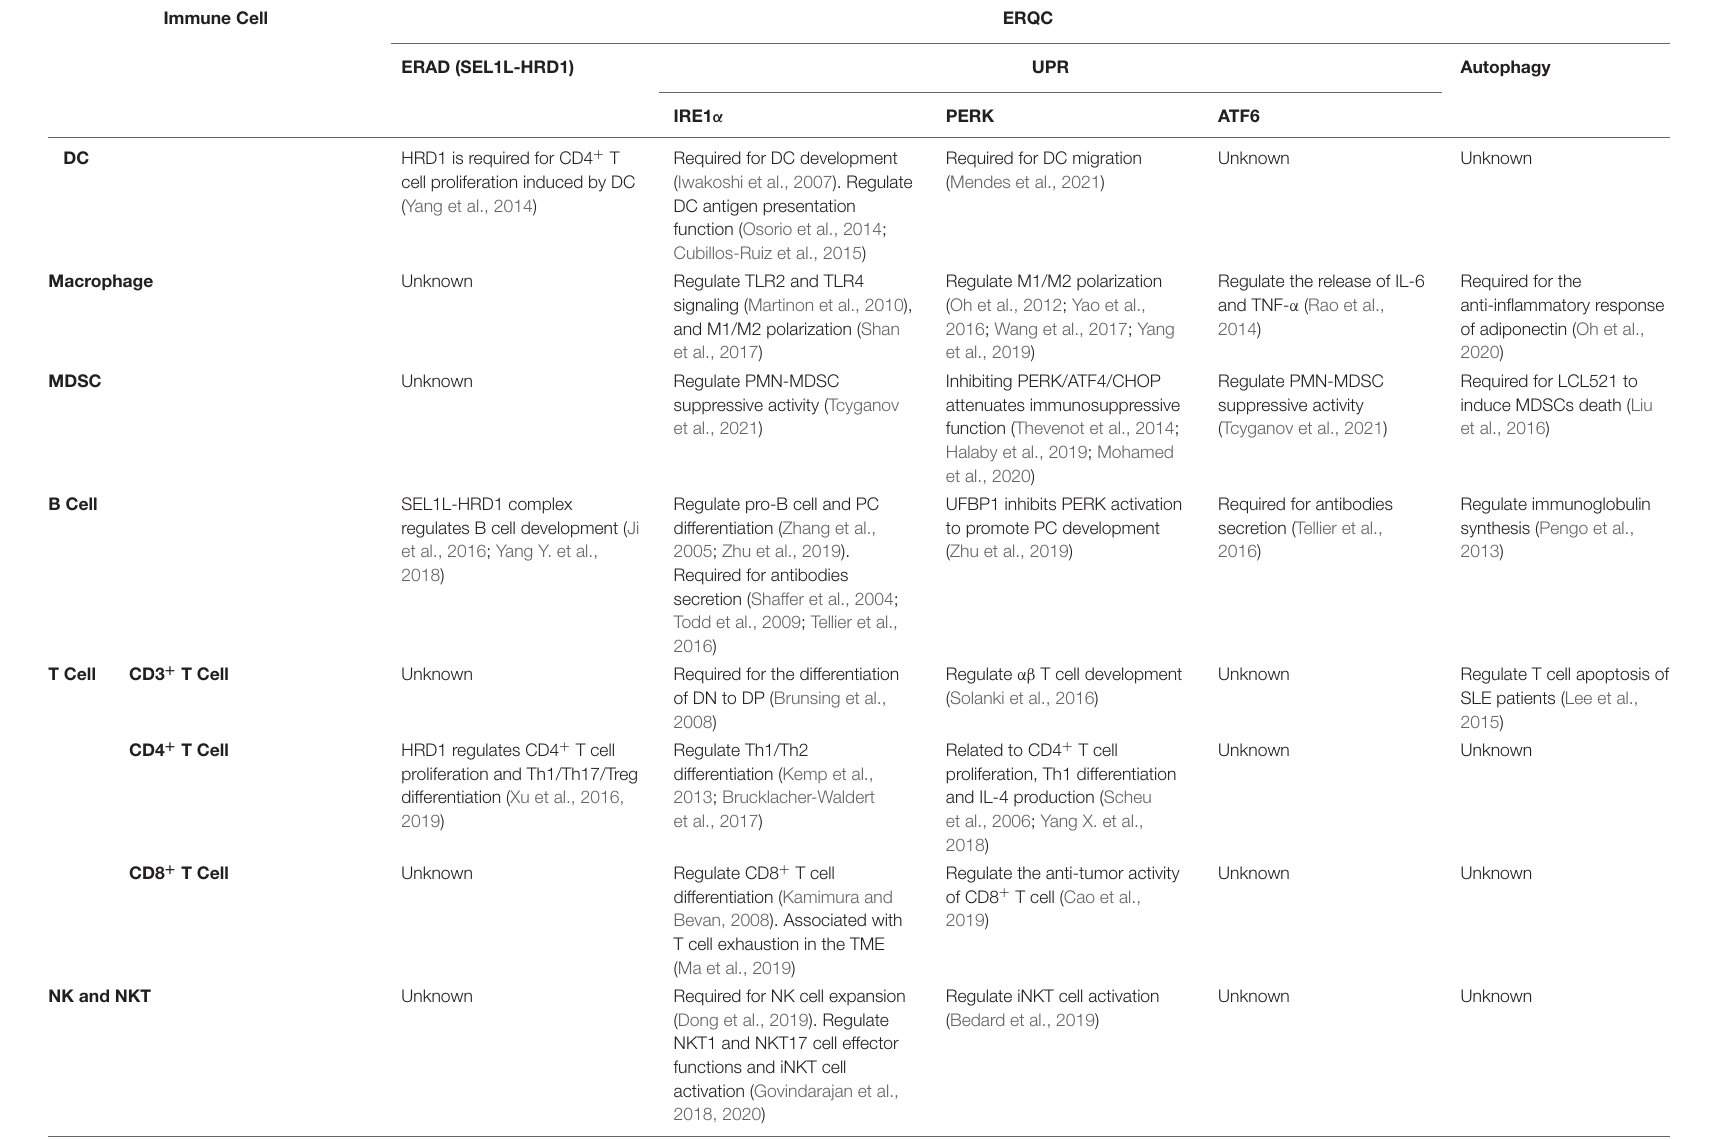
TABLE 1 | ERQC regulates the differentiation and function of immune